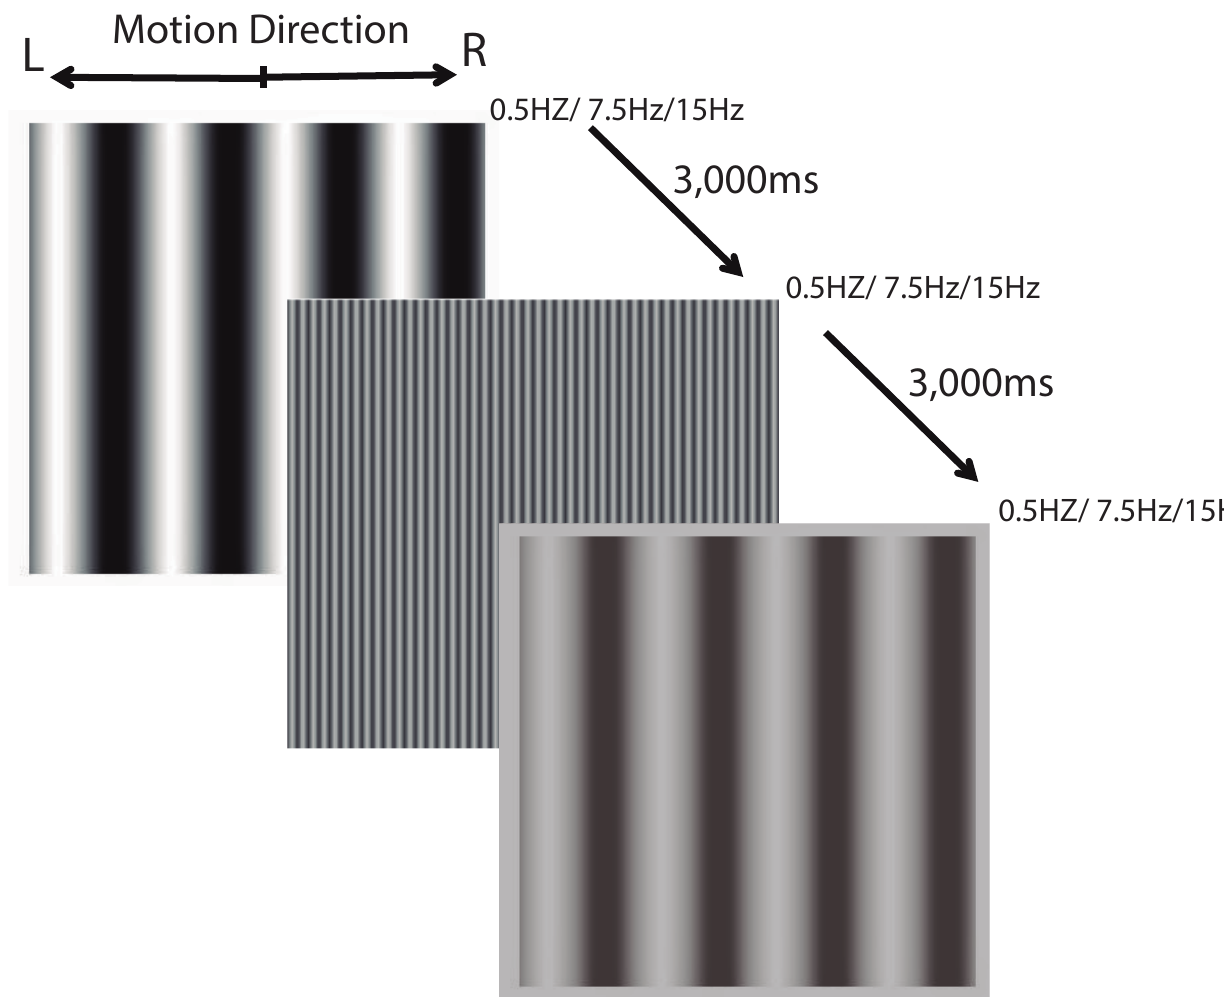
Figure 1. The illustrative timeline of the testing session. A spatial frequency randomly chosen was presented by 1 s, moving rightward or leftward in an also randomly chosen temporal frequency. The patient had up to 3 s to judge the movement of the grating in a two-AFC